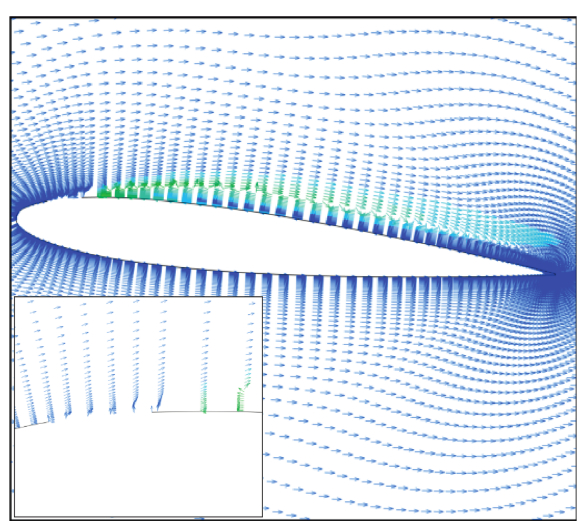
Figure 5: “10 ∼ 4” velocity vector nephogram.